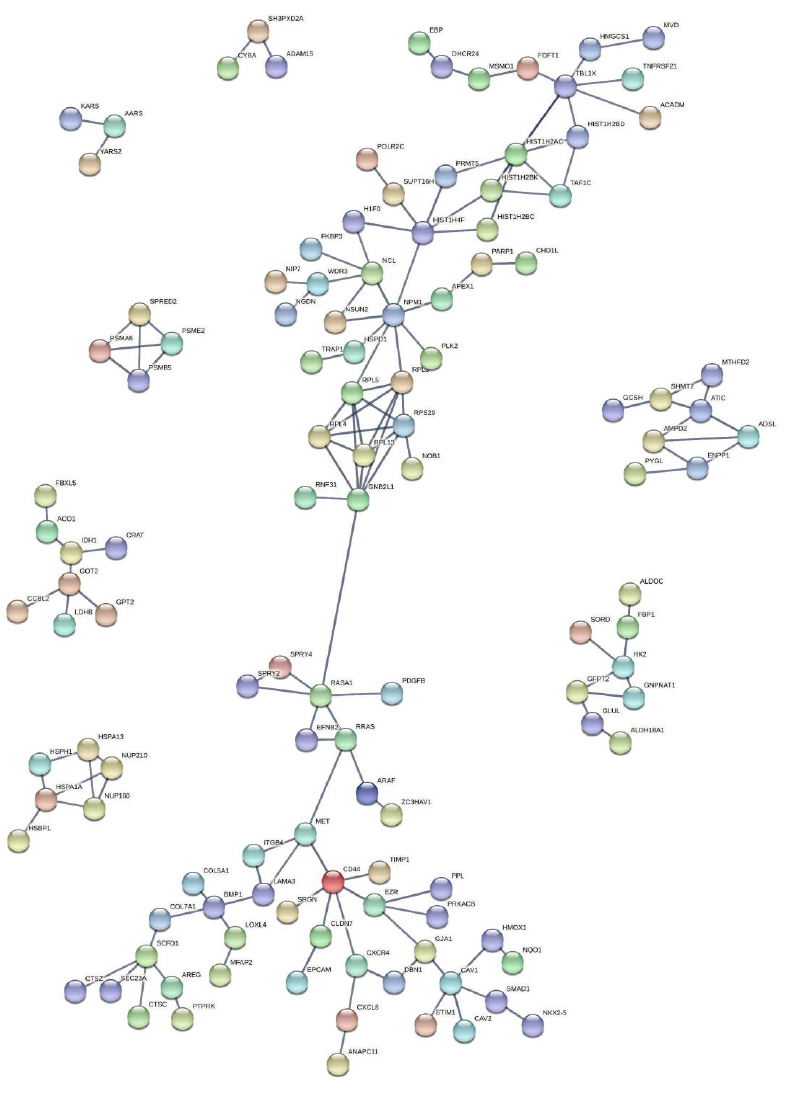
Figure 3. Functional enrichment analysis: STRING plot of interaction network functional enrichment analysis for all 512 genes based on the 549 genes from Supplementary Table S3. The connecting lines indicate the degree of interconnection and enrichment in certain molecular